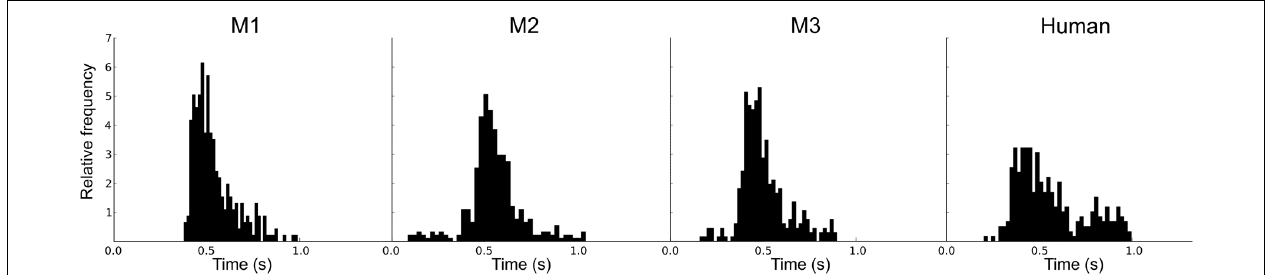
FIGURE 2 | Individual reaction time histograms showing the distribution of the reaction times for successful test trials (hits) separately for the three macaques, and a comparison distribution for a human.